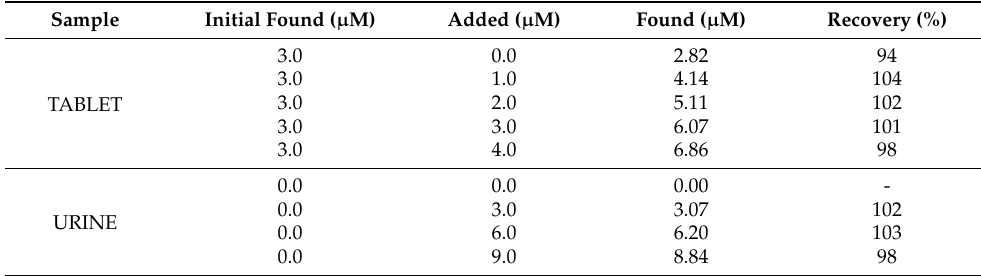
Table 4. Determination of FA in drug tablet and urine samples by applying differential pulse voltam- metry at the surface of CPE